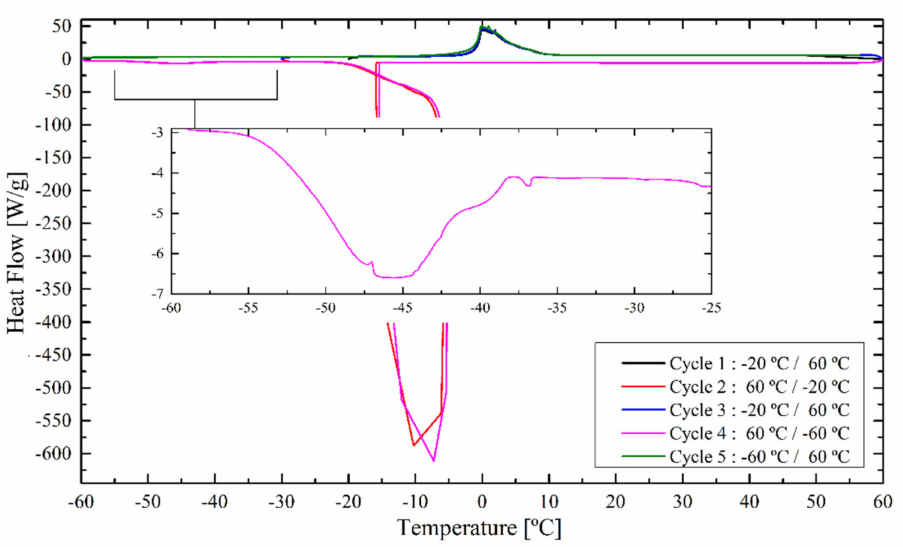
Figure 7. DSC measurement of the REF latex immersed for one week in